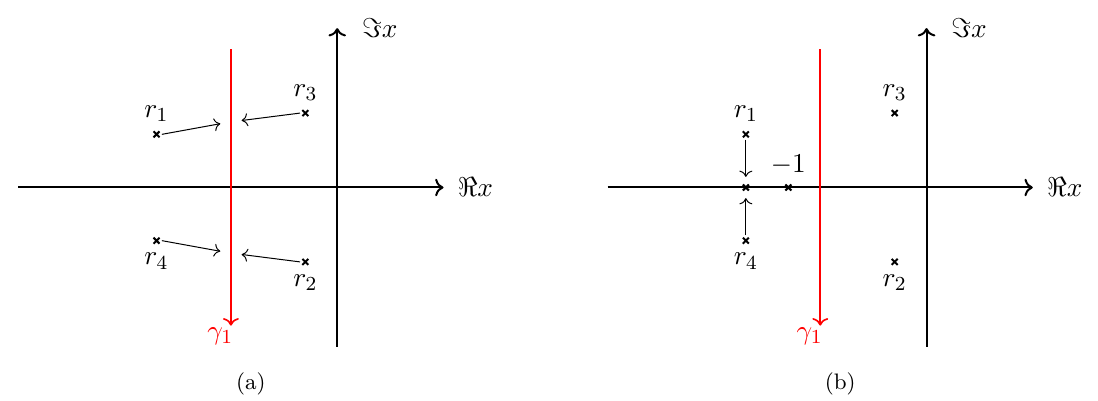
Figure 3 . The roots of y 2 ( x ) for the sunrise integral coincide in the null-momentum limit (a) and pseudo-thresholds (b). In the latter case, the position of the coinciding roots relative to − 1 is shown for the case t 3 > t 1